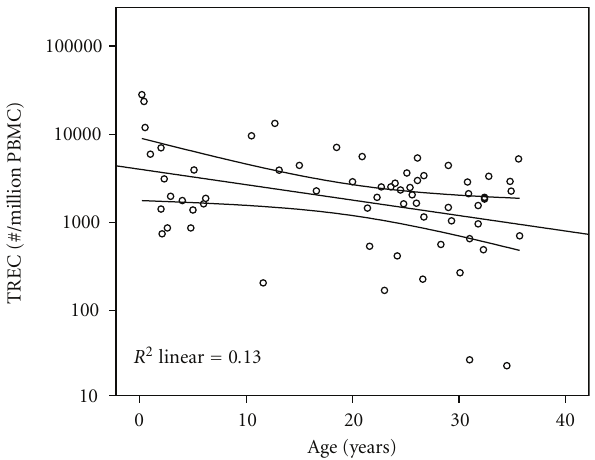
Figure 1: TREC values versus age for subject classification. Age adjusted mean and 99% confidence interval for the mean are displayed. Subjects with TREC values falling below the 99% confidence interval are included in the “low TREC”